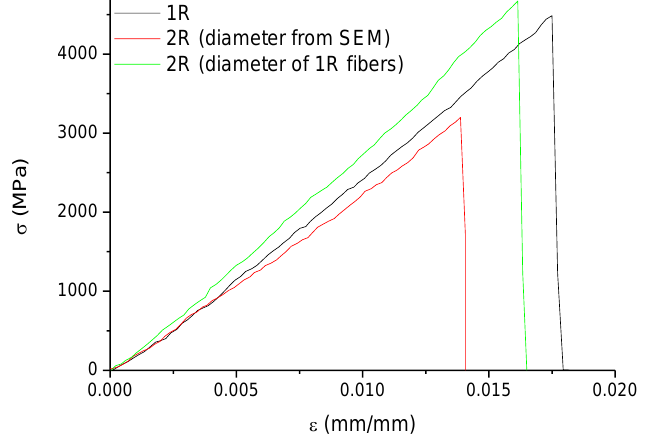
Figure 10. Tensile tests on 1R and 2R carbon fibers.